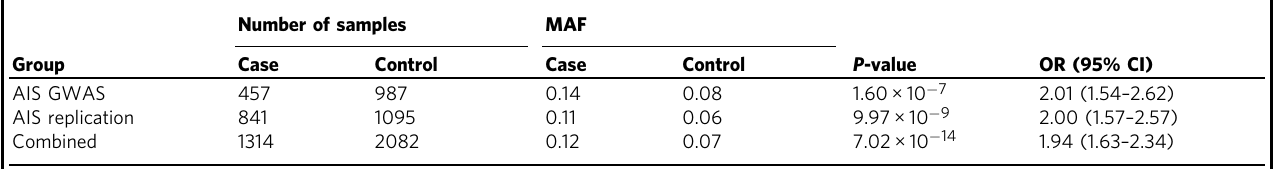
Table 1 Association of rs13107325 with adolescent idiopathic scoliosis Number of